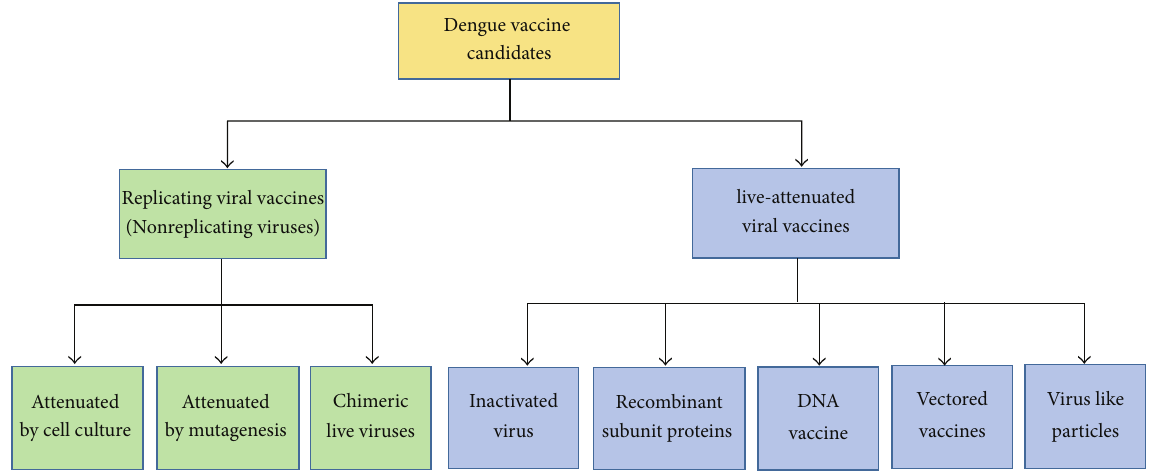
Figure 5: Classification of dengue vaccine